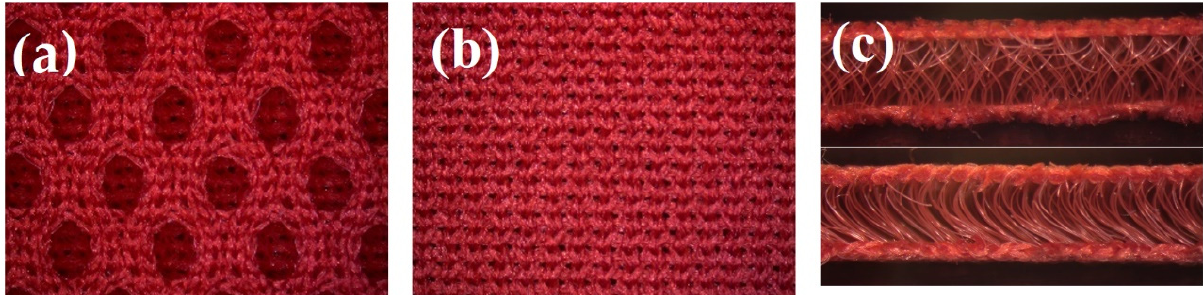
Figure 4. The visualization of spacer knitted fabric (I) designed in ProCad Warpkni. For each of the knitted fabrics, photographs of the right and left sides were taken using OPTA-TECH’s X2000 stereoscopic microscope (Warsaw, Poland). For the 3D fabric, cross-sectional photos were also taken (Figure 5).